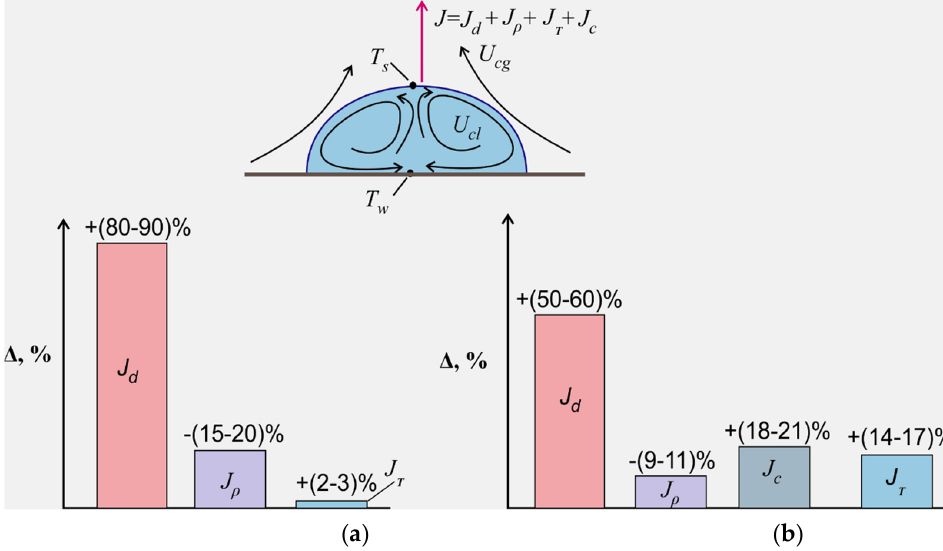
Figure 14. Influence of key factors on droplet evaporation, Δ = 100% ( J w , s − J w )/ J w . ( a ) T w = 20–21 °C, ( b ) T w = 90 °C. Key: J w (kg/s) —pure water mass flux, J w , s —solution mass flux for surfactant concentration of 10,000 ppm, J d —drop diameter effect, J ρ —partial pressure of water vapor effect, J c —thermogravitational convection effect, and J T —nonisothermality effect.